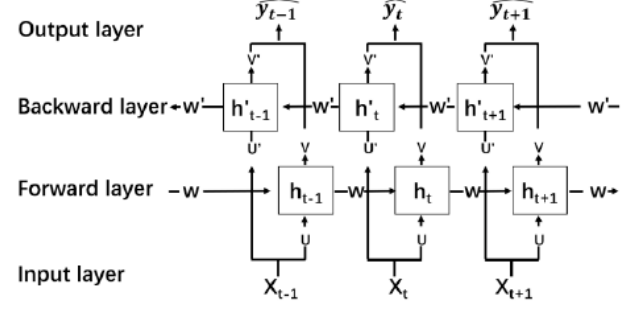
Figure 5. The structure of BiLSTM network.